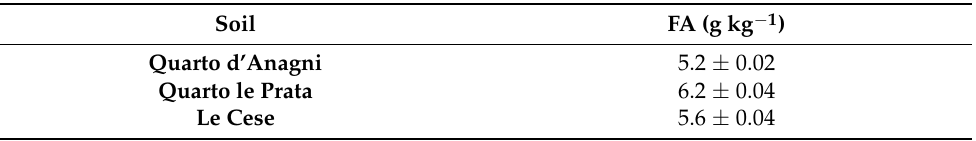
Table 2. Quantities of FA, expressed in g kg − 1 , extracted from the soil samples taken at the study sites (data are averages of four samples, analyzed in triplicate; n =